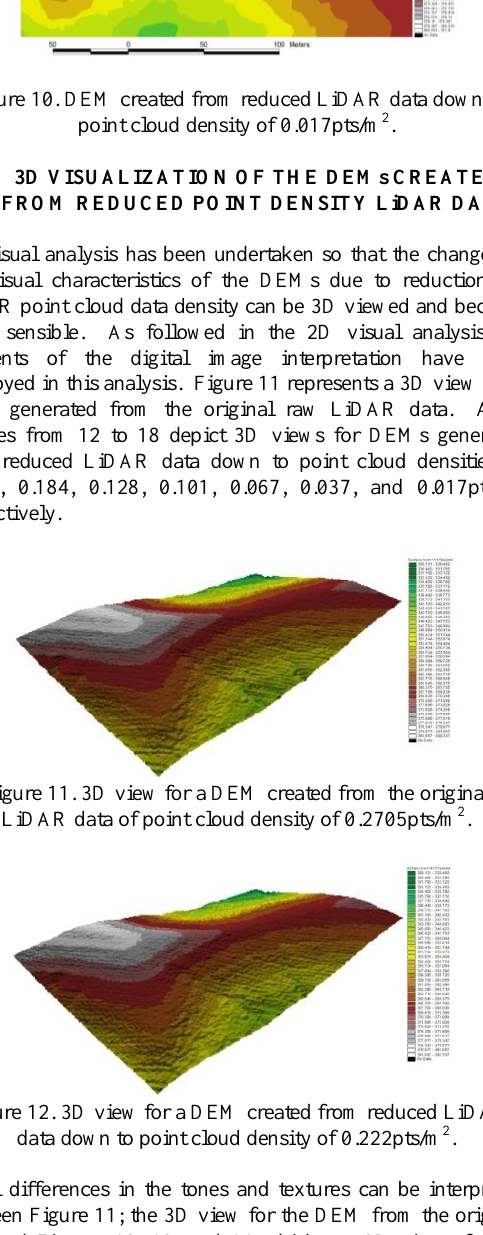
Figure 13: 3D view for a DEM created from reduced LiDAR data down to point cloud density of 0.184pts/m 2 .